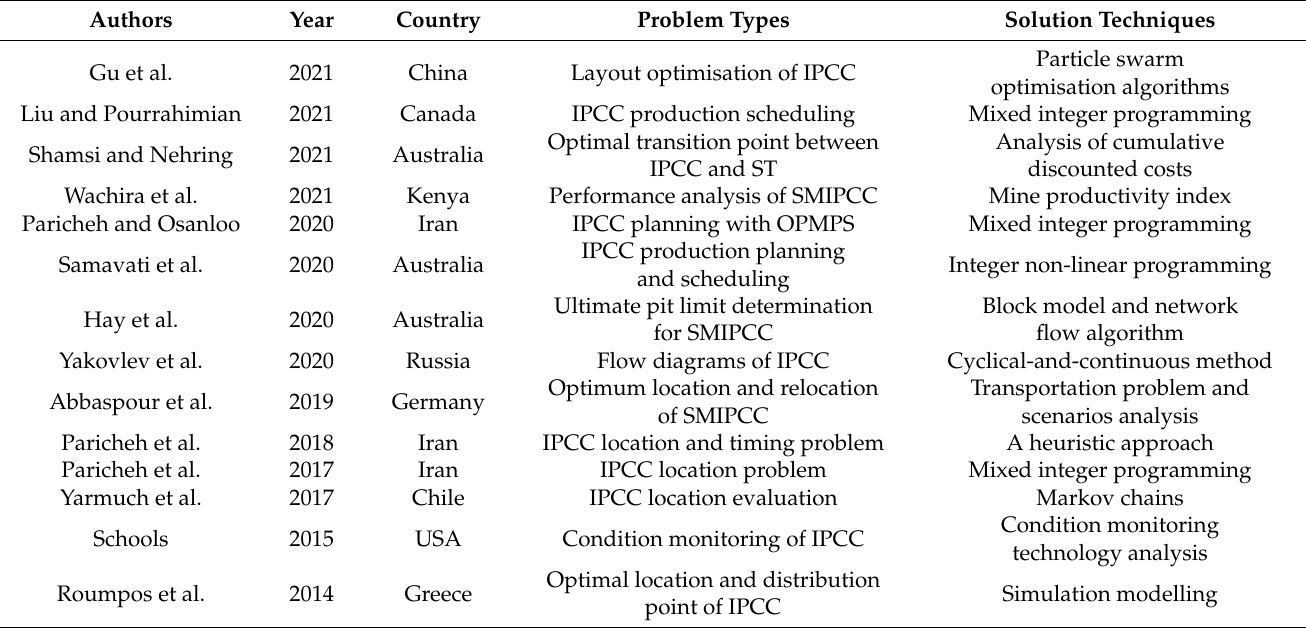
Characteristics analysis of publications on the in-pit crushing–conveying (IPCC) system